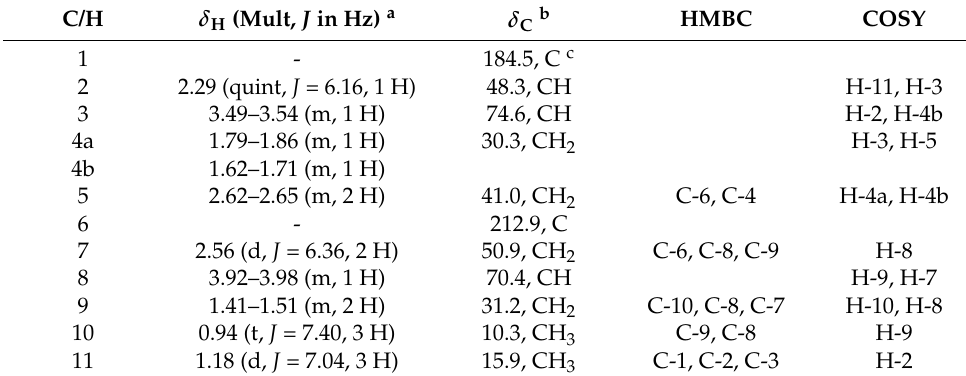
Table 1. NMR spectral data for 1 in CD 3 OD.